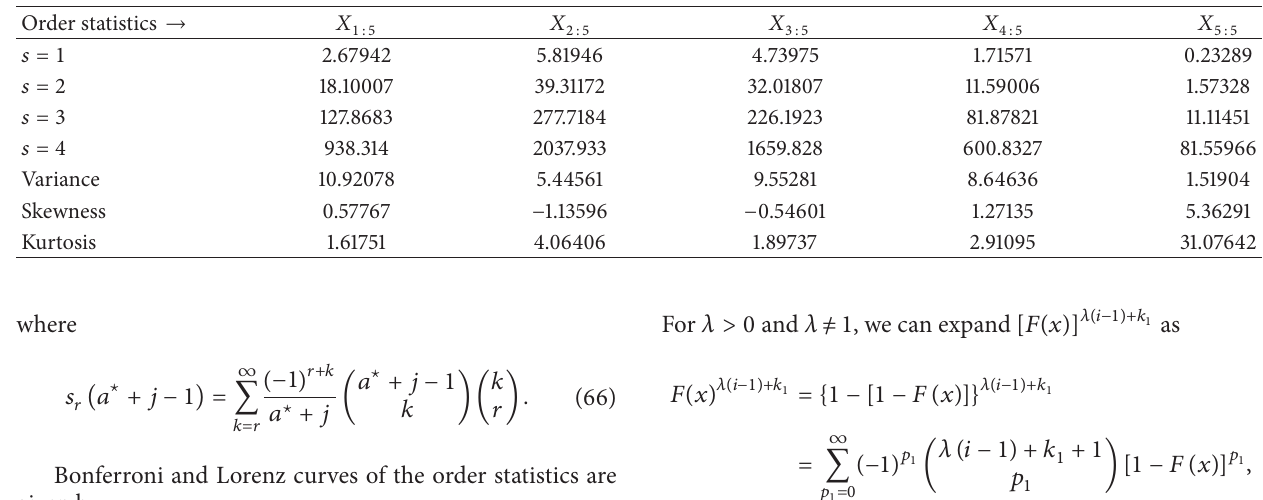
Table 1: Moments of the BGHN order statistics for 𝜃 = 8.5 , 𝛼 = 3 , 𝑎 = 2 , and 𝑏 = 3